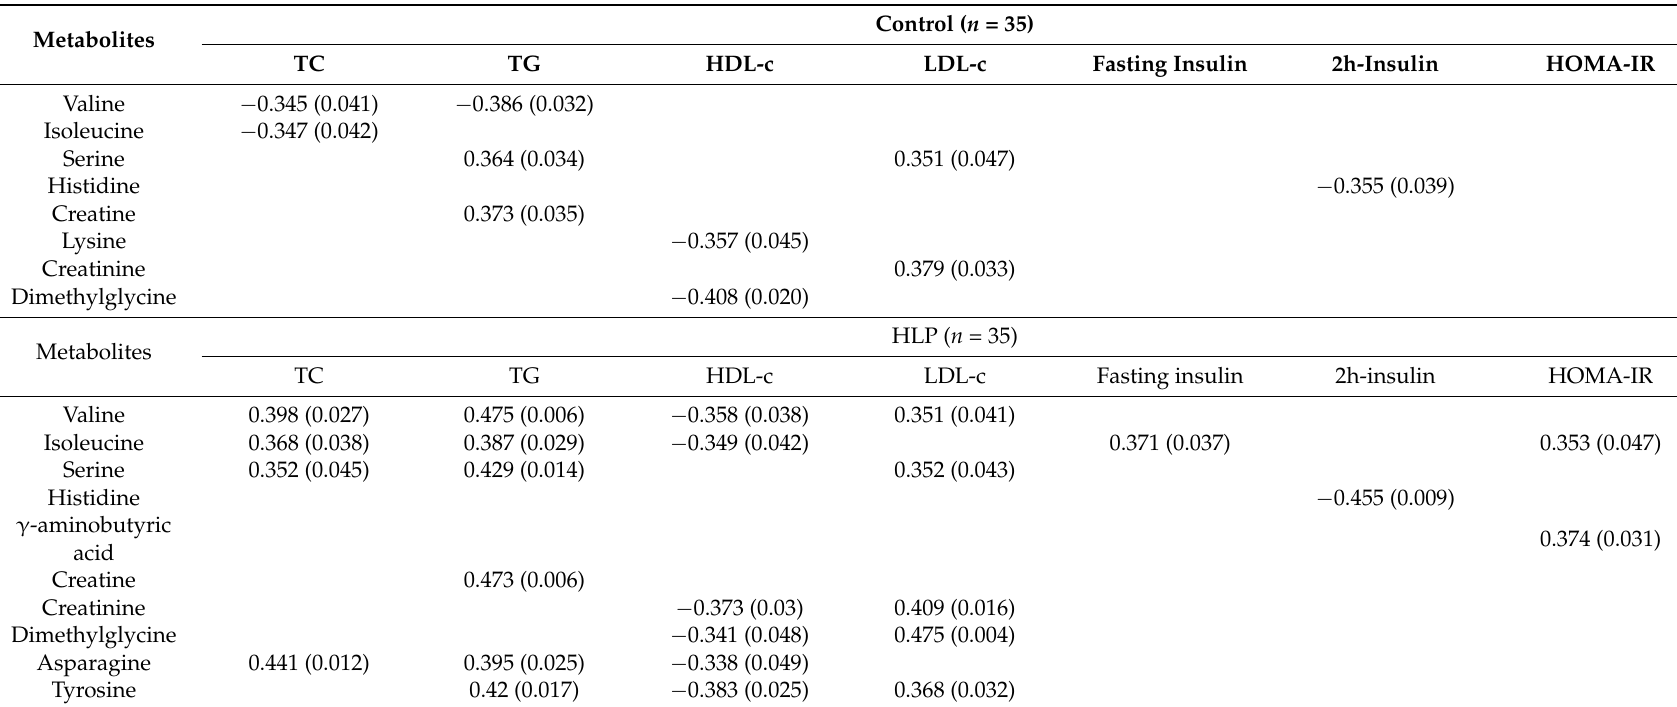
Table 3. Associations between clinical parameters and percent change of metabolites from fasting to 2-h sample response to an